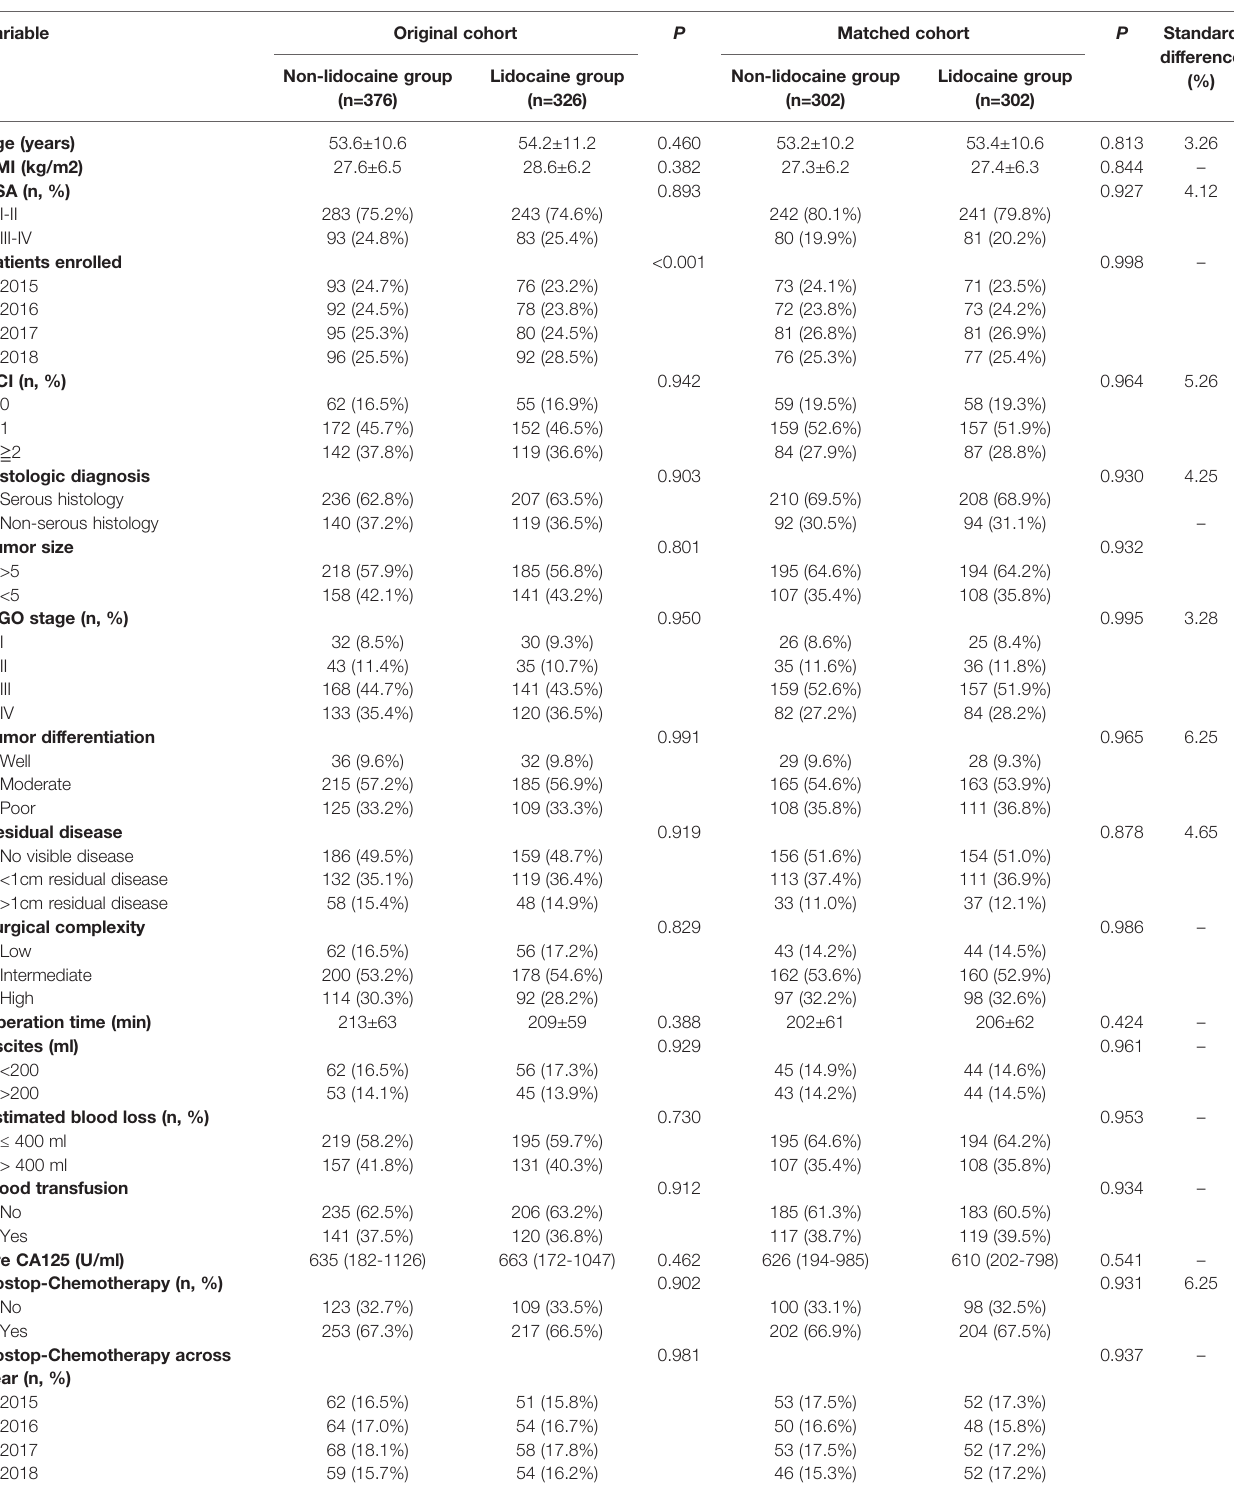
TABLE 1 | Patient and treatment characteristics for both